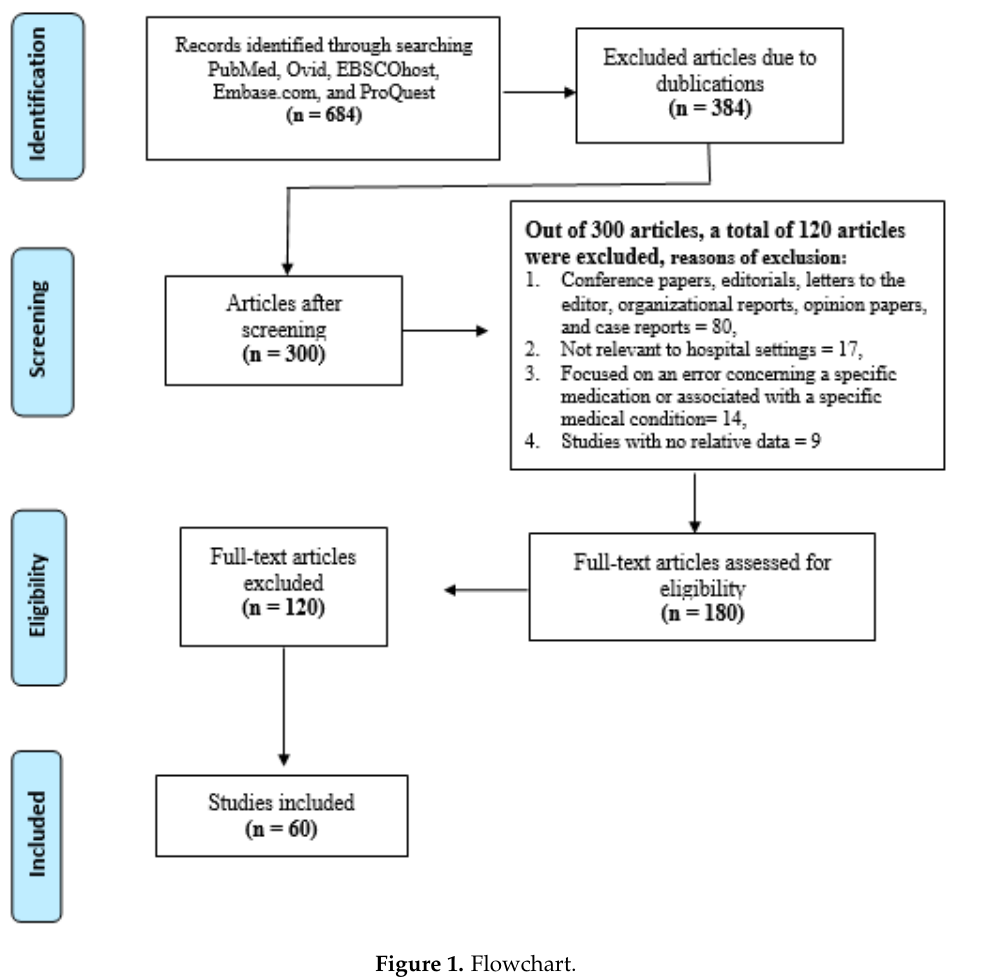
Figure 1. Flowchart. Figure 1.